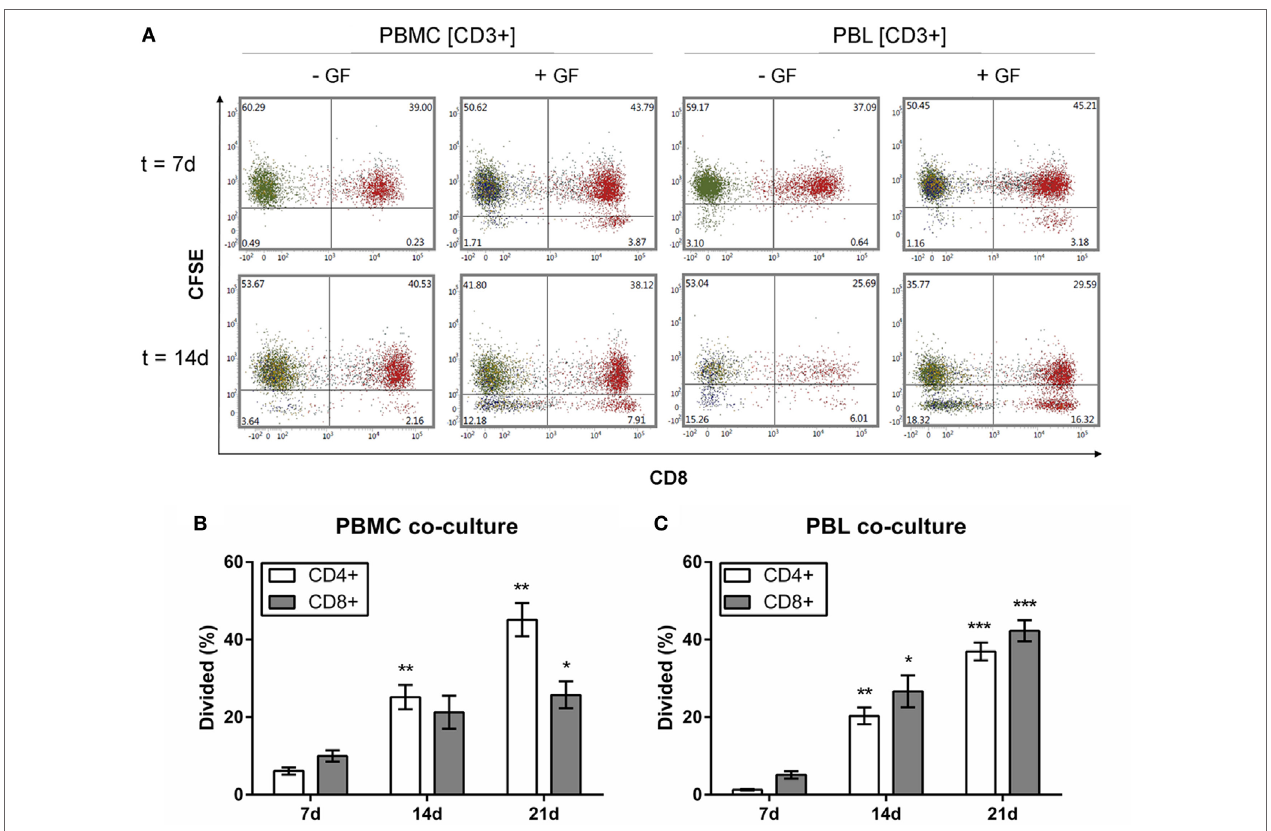
FigUre 8 | CD3 + CD4 + and CD3 + CD8 + cells proliferate in the presence of gingival fibroblasts (GFs). Quantification of proliferating Carboxyfluorescein succinimidyl ester (CFSE)-labeled CD3 + cells over time. (a) Dot plots of CD3 + cells within peripheral blood mononuclear cell (PBMC) (left panels) and peripheral blood lymphocyte (PBL) (right panels) cocultures after 7 (upper panels) and 14 days (lower panels). CFSE intensity is plotted on the y -axis and CD8 + is plotted on the x -axis. CD3 + CD8 + cells are shown in red, CD3 + CD8 − (CD3 + CD4 + ) cells are shown in green. Numbers in lower quadrants indicate the percentages of cells that have divided. (B) Quantification of the divided CD4 + (white bars) and CD8 + (gray bars) cells (normalized percentages ± SEM) in PBMC cocultures over time. (c) Quantification of the divided CD4 + (white bars) and CD8 + (gray bars) cells (normalized percentages ± SEM) in PBL cocultures over time. All significant differences were compared to 7 days. n = 5 GF donors, * p < 0.05, ** < 0.01, *** <